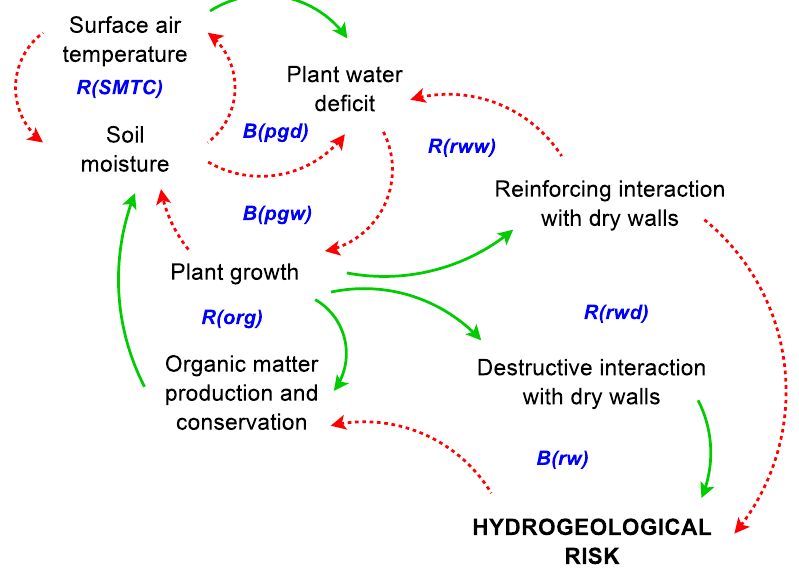
Figure 18. Map of positive interactions with dry walls R(rww) and R(wrd) and destructive interaction with dry walls B(rw). The CLDs R(rww) and R(wrd) can play a role in TAS expansion and conservation whilst B(rw) plays a limiting role in TAS’s expansion and